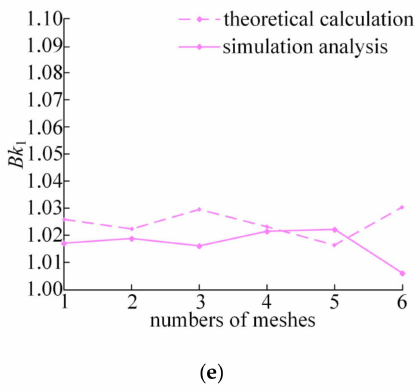
Figure 8. Comparison of load proportional coefficient curves under different loads: ( a ) 2 N · m;